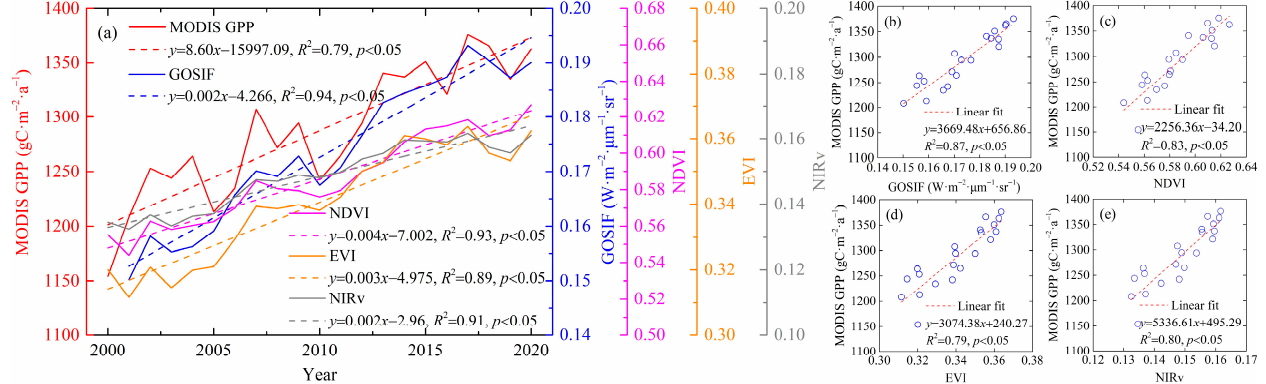
Figure 4. Temporal variations of annual mean MODIS GPP and GOSIF, NDVI, EVI, and NIRv ( a ) and their linear fit ( b – e ) during 2000–2020.